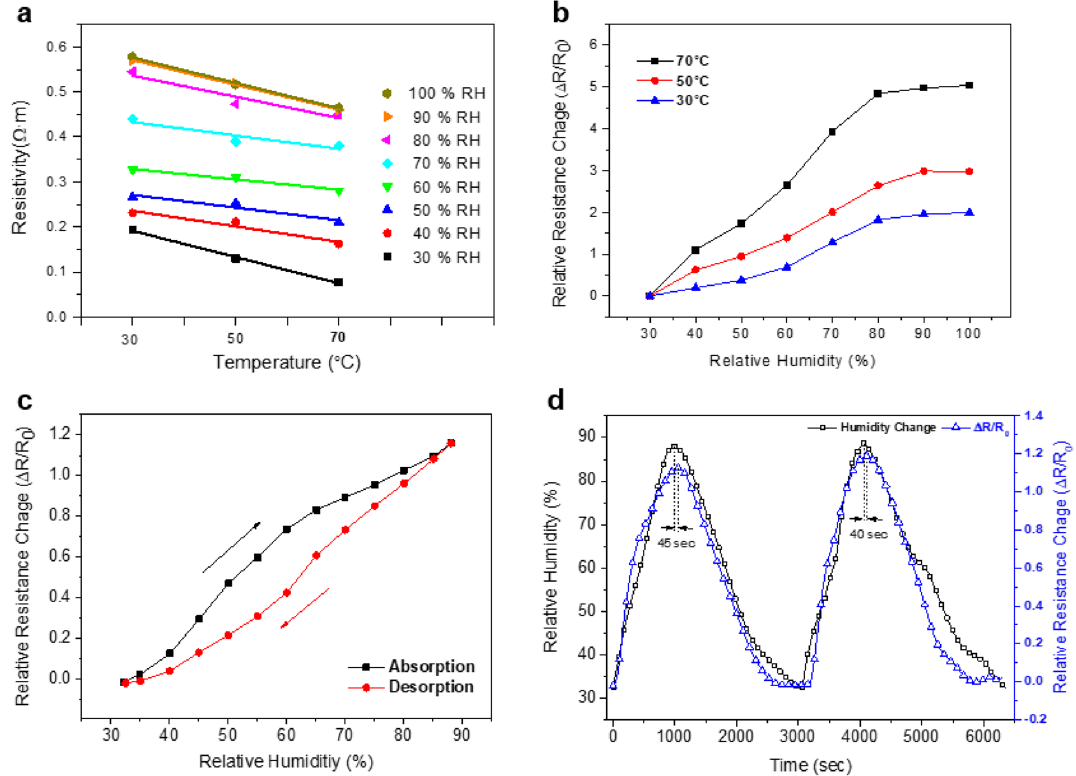
Figure 10. ( a ) Resistivity versus temperature at different RH from 30 to 100%. ( b ) Relative resistance change versus RH with different temperatures. ( c ) Hysteresis characteristics of humidity sensing by CNGO 5 hybrid filament. ( d ) Time response of the sensor with cyclic RH